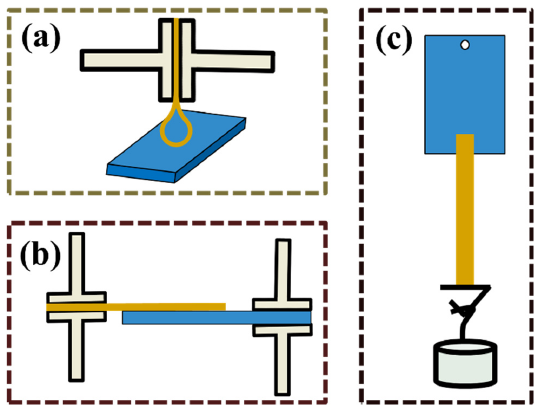
Figure 2. Schemes of bond strength test: ( a ) loop tack test; ( b ) 180° peel test; ( c ) holding power test (In this figure, the tape samples were colored with yellow, and the stainless steel panels were colored with blue).